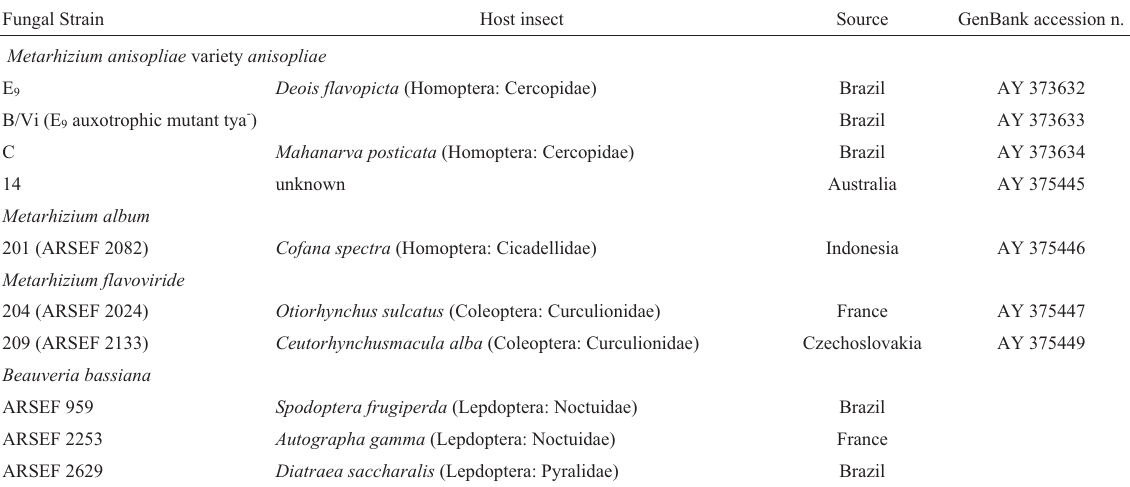
Table 1 - Fungal strains used in this study and their insect hosts. Fungal